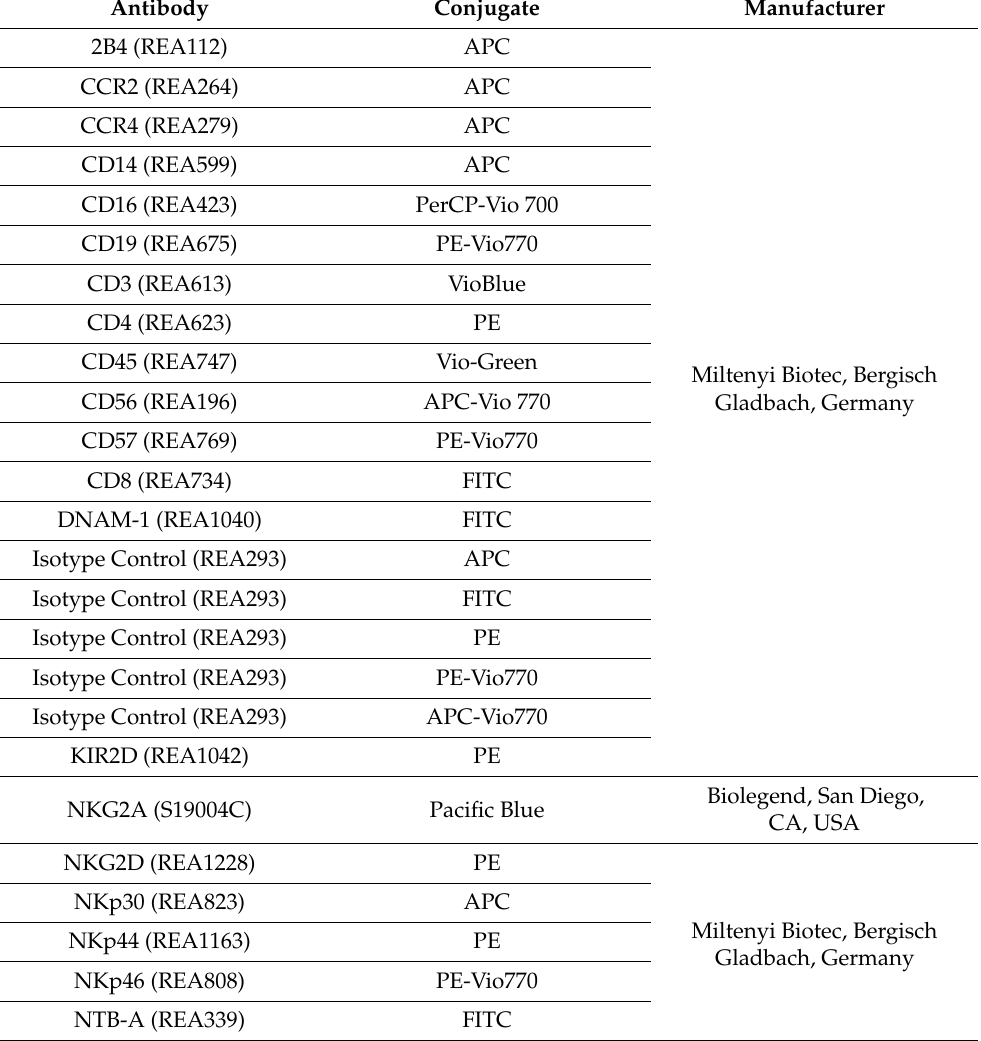
Table 1. Antibody